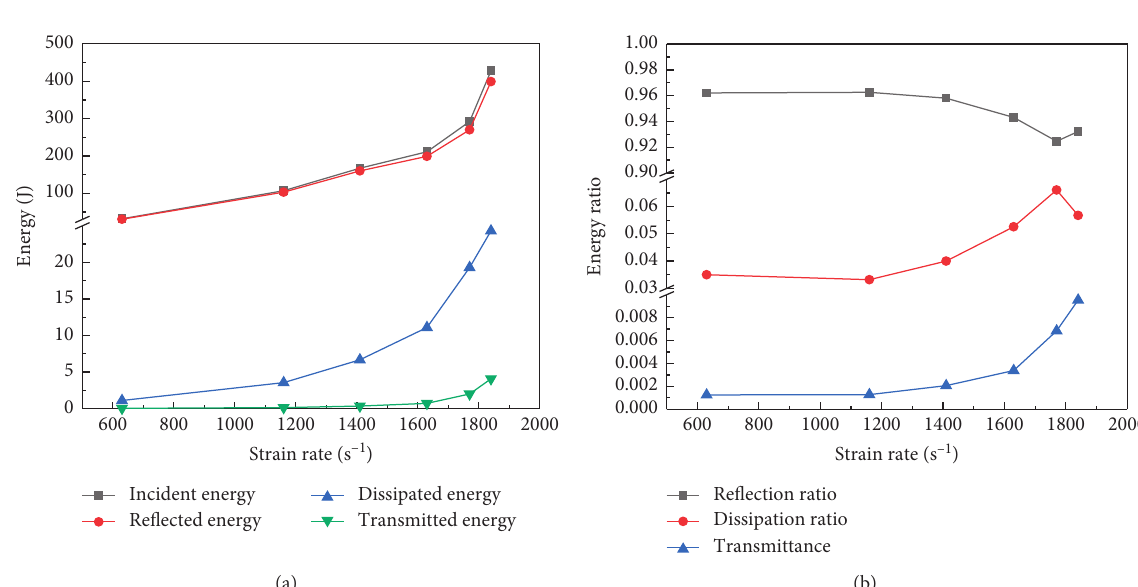
Figure 10: (a) Incident energy, reflected energy, dissipated energy, and transmitted energy at different strain rates; (b) energy ratio at different strain